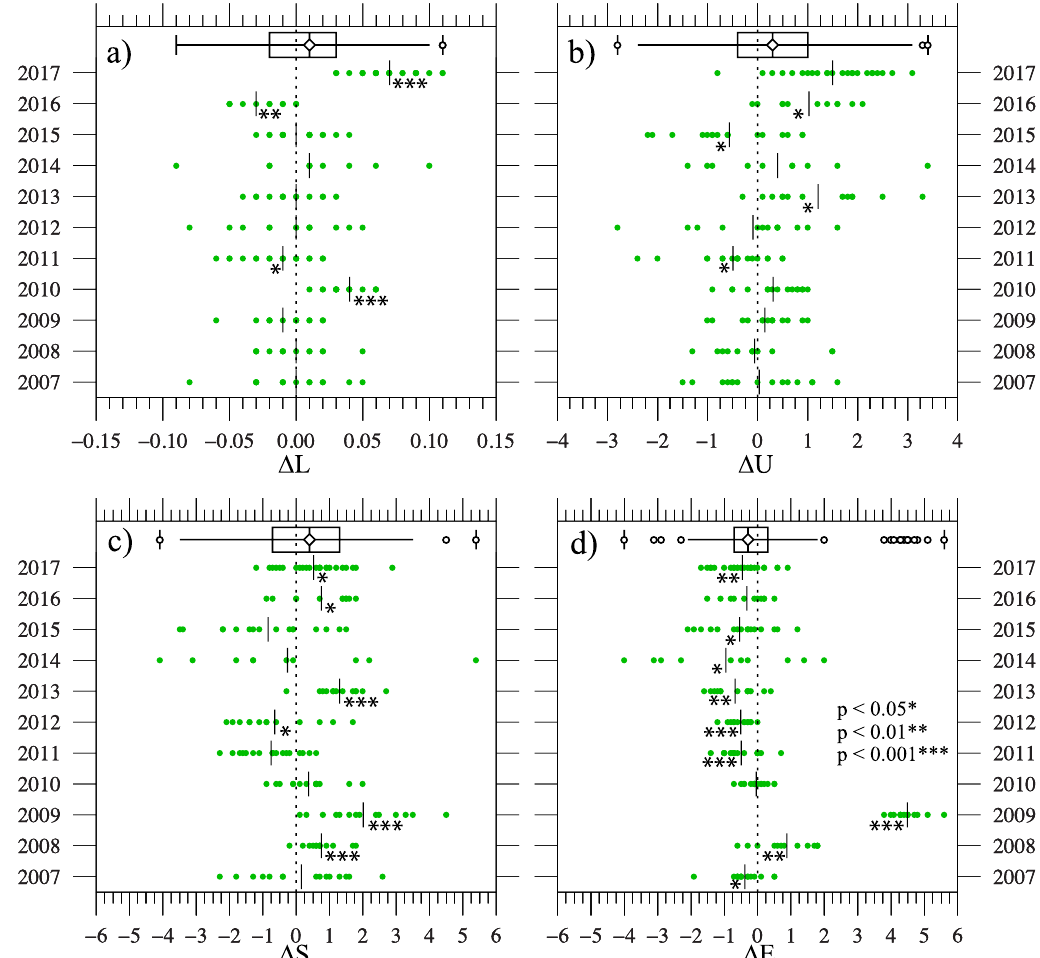
Figure 6. ( a ) Scatterplot of May-planted minus June-planted fiber length e ff ects ( ∆ E) calculated from the same cultivar during each year. Bar plot marks 2007–2017 ∆ E value’s minimum and maximum, and 25th, 50th and 75th percentiles. ( b ) As in ( a ) for May-planted minus June-planted fiber uniformity e ff ects ( ∆ U). ( c ) As in ( a ) for May-planted minus June-planted fiber strength e ff ects ( ∆ S) ( d ) As in ( a ) for May-planted minus June-planted fiber elongation e ff ects ( ∆ E).